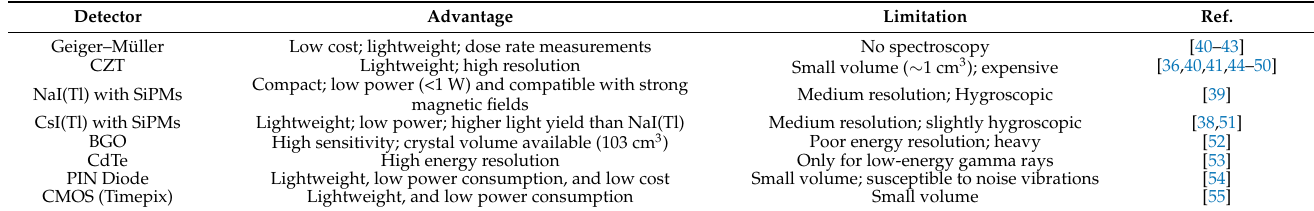
Table 2. Recent gamma-ray detection systems coupled to a multirotor.